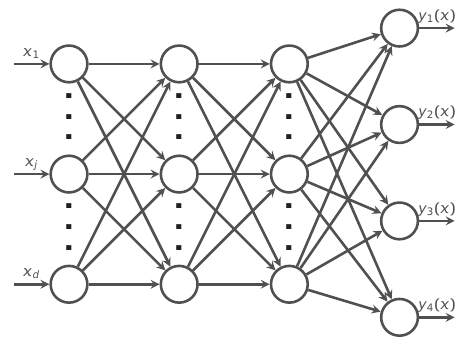
Figure 3: Neural network